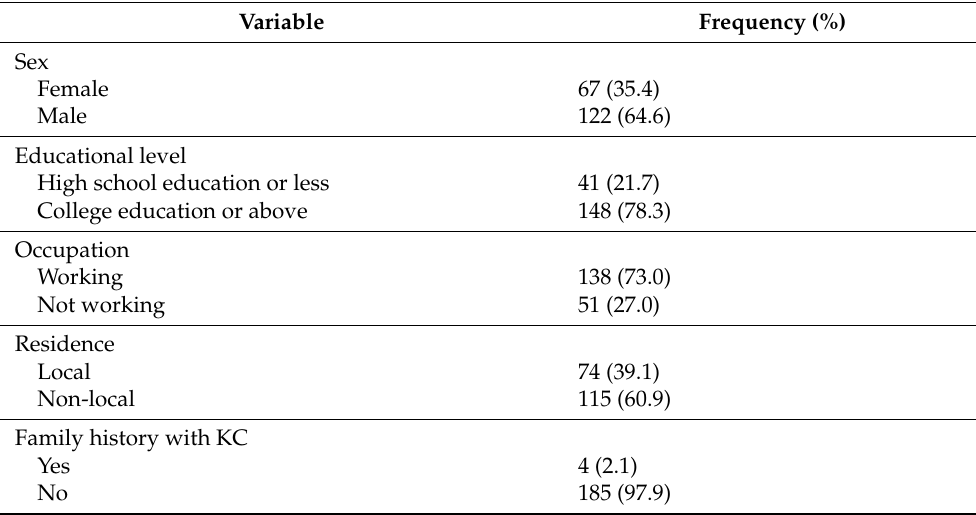
Table 1. Demographics of the respondents (n =